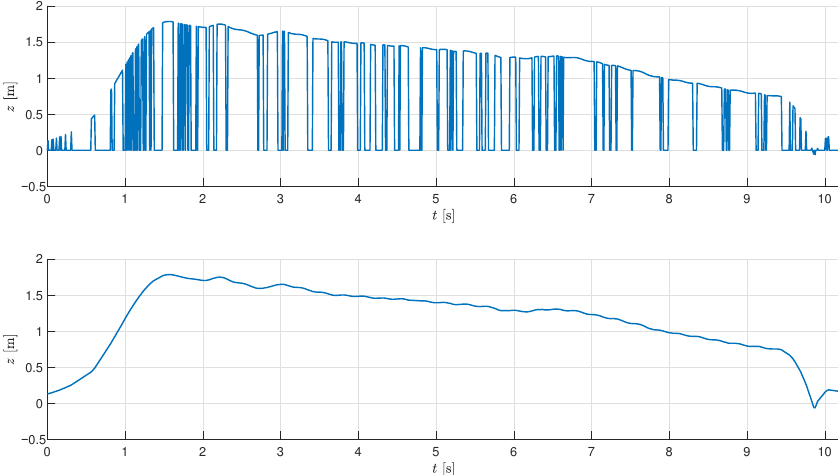
Figure A1. Interpolated data from the OptiTrack